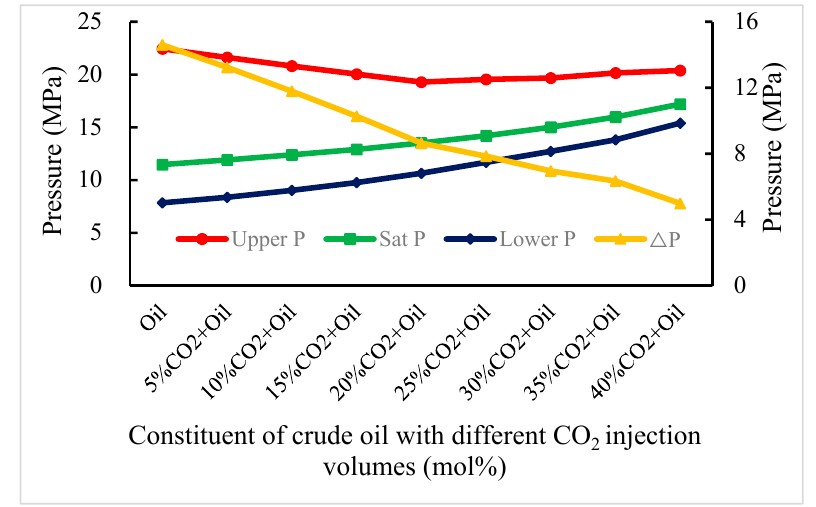
Figure 2. Asphaltene deposition pressure change with different injection volumes of CO 2 at 65 °C in a shallow reservoir.